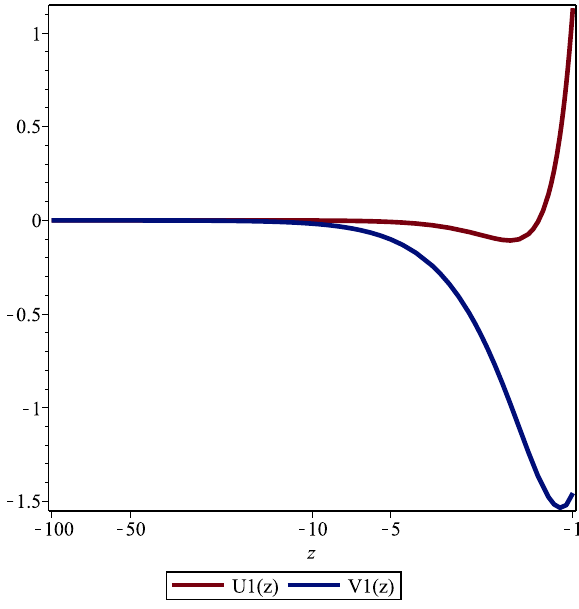
Figure 1. Graphs of functions U 1 ( z ) and V 1 ( z )